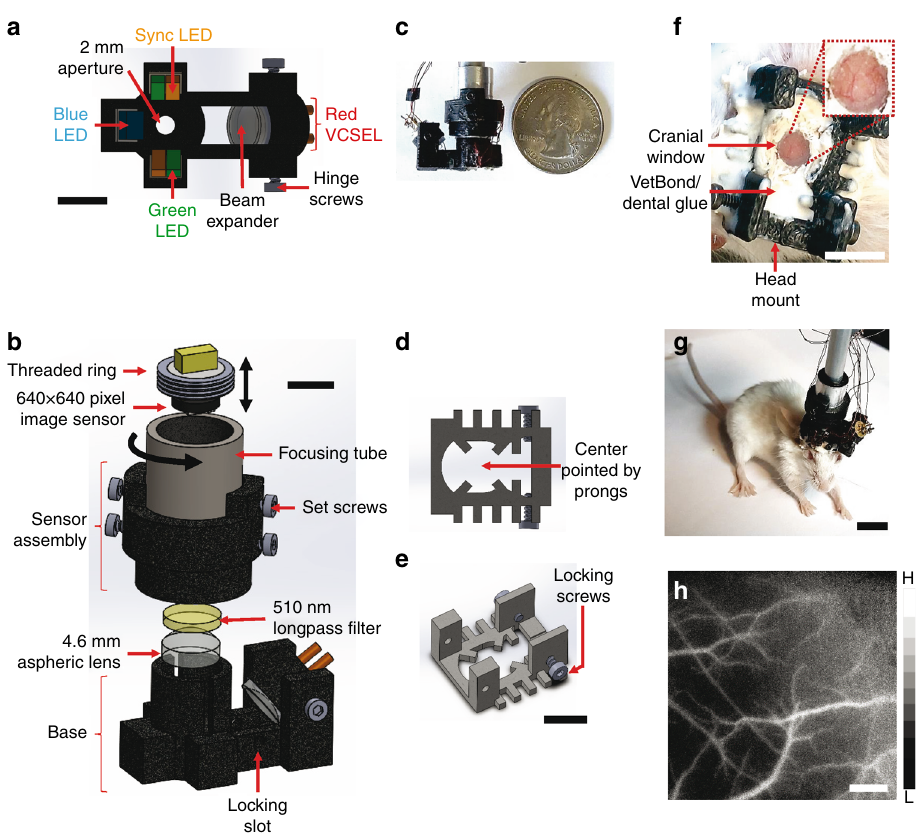
Fig. 1 Miniature plug-and-play design with three optical contrast mechanisms. a A bottom view of the microscope base unit. Excitation for green fl uorescent imaging is provided by a blue LED, while HbT imaging is carried out with a pair of green LEDs. A red laser diode in conjunction with a beam expander and hinge screws facilitates dHb and LSC imaging. A separate pair of orange (sync) LEDs is used for synchronizing with external instruments (e.g., an EEG system). The FoV lies directly below the aperture. b The sensor unit of the microscope shown along with the base consists of a 4.6 mm focal length lens, a 510 nm long-pass fi lter to block blue fl uorescence excitation light, a focusing tube and an image sensor. c The complete microscope assembly is shown with a U.S. quarter coin next to it for scale. d , e Bottom and side views of the head mount, respectively. The head mount is surgically implanted on the rodent ’ s skull and enables fi rm attachment of the microscope via a pair of locking screws. The pronged structure at the base of the head mount facilitates centering on the FoV. f Head mount attached to a mouse skull with the inset showing the cranial window for optical access to the brain. g A freely moving mouse with the microscope. h A grayscale CBF map acquired with the microscope from an awake mouse using LSC imaging. The microscope housing was rapid prototyped and 3D printed, which permitted a high degree of customization. Scale bar indicates 5 mm in a , b , and f , 1 cm in g and 500 µ m in h . Also see Supplementary Figs. 1, 2 and